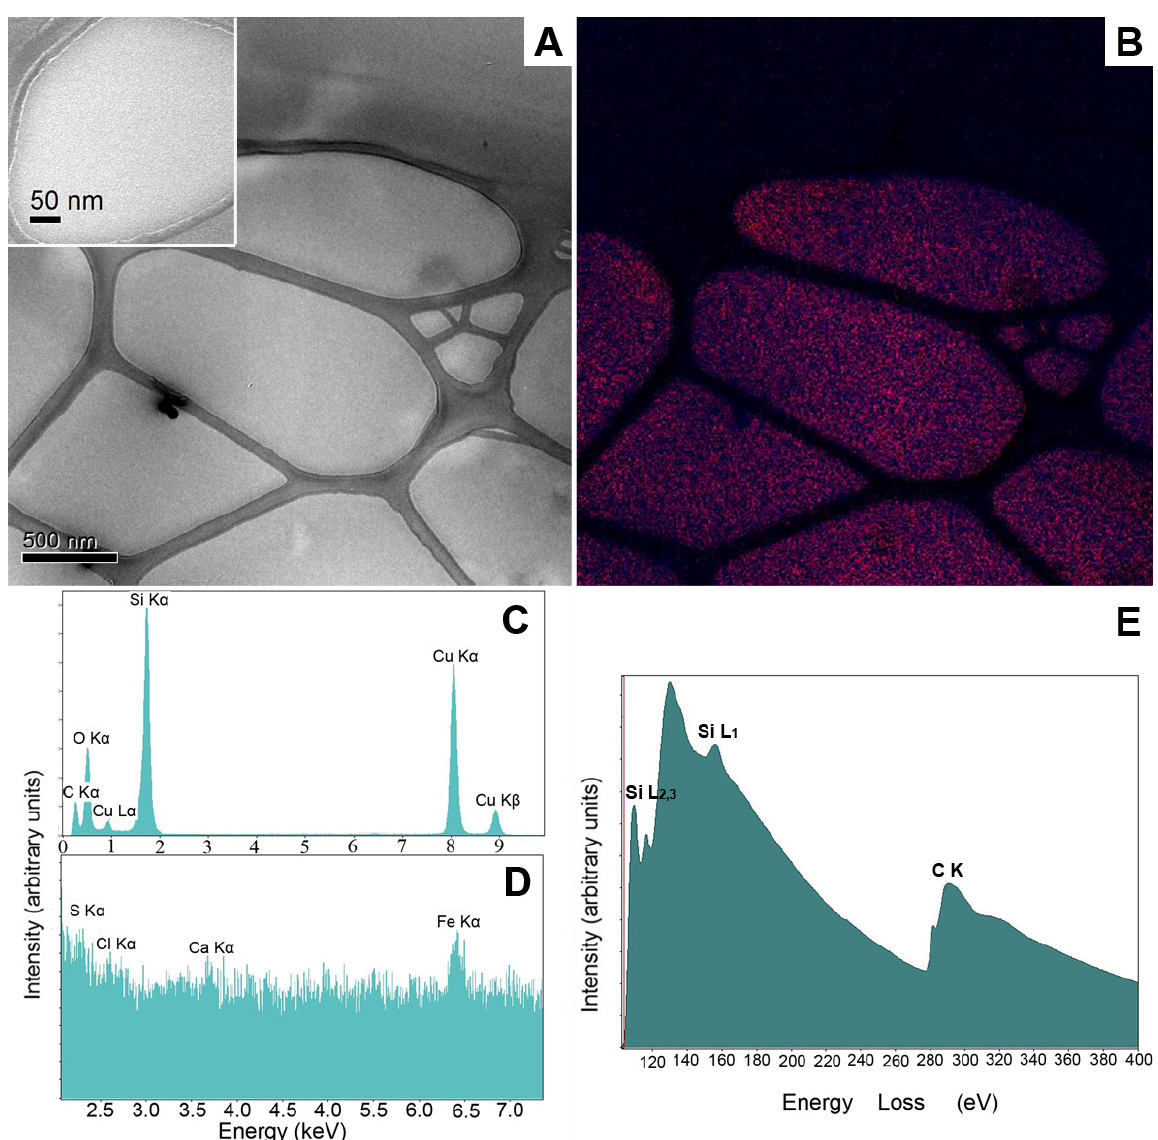
Figure 5. ATEM characterization of a commercially available liquid formulation containing unspecified nanomaterial by EFTEM, EDXS and EELS analyses without prior staining. Image ( A ) shows a zero-loss filtered bright field image of the formulation (scale bar represents 500 nm). In image ( B ), a multicolored EFTEM image of the elemental distribution within the formulation is given. The elemental distribution of silicon (blue) and oxygen (red) is documented in different colors. Images ( C ) and ( D ) show EDXS spectra of the same formulation with two different energy scales. In image ( E ), an EELS spectrum of the silicon (Si L) and carbon (C K) ionization edges are